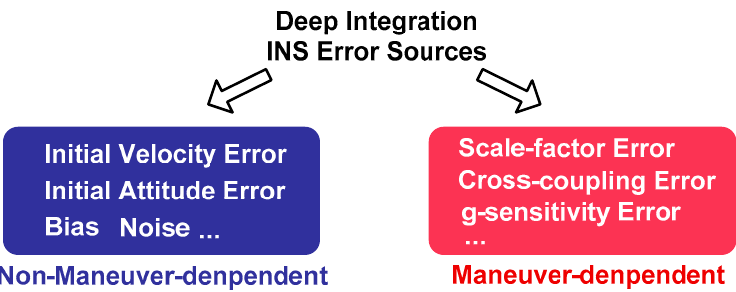
Figure 2. The classification of the INS error sources in the GNSS/INS deep integration.